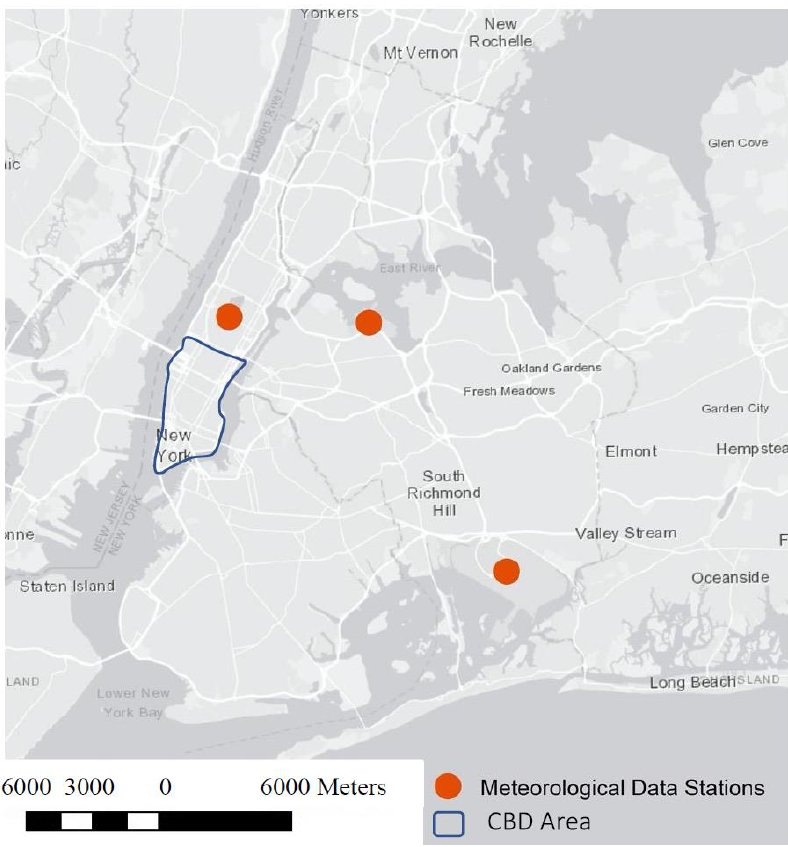
Figure 2. Meteorological data stations.